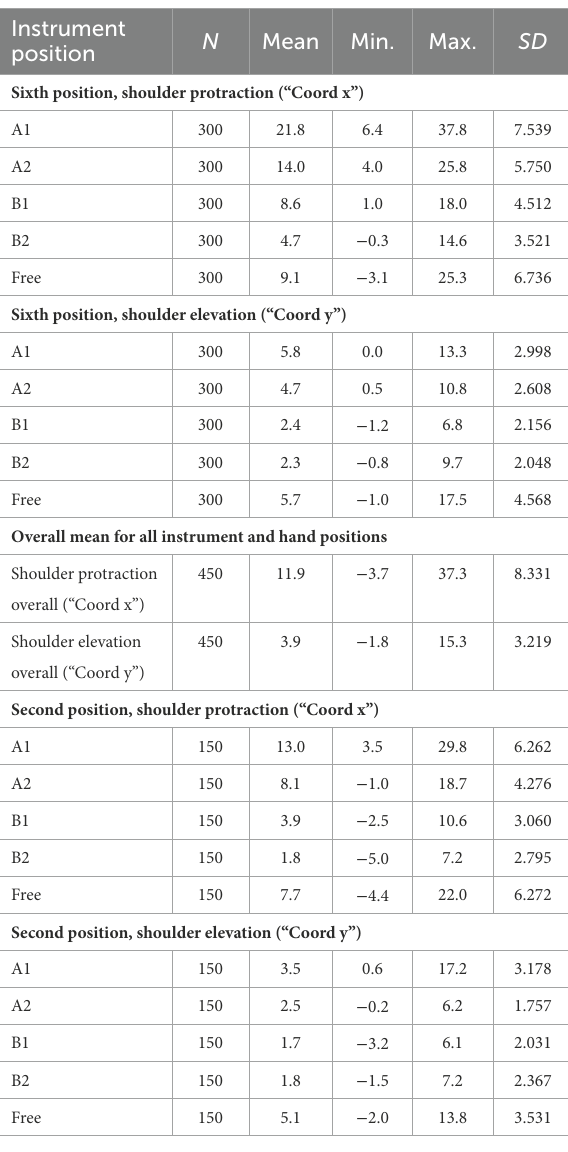
Multiple regression analysis for “Reference Angle α” in TABLE 5 Descriptive statistics for shoulder compensation movements